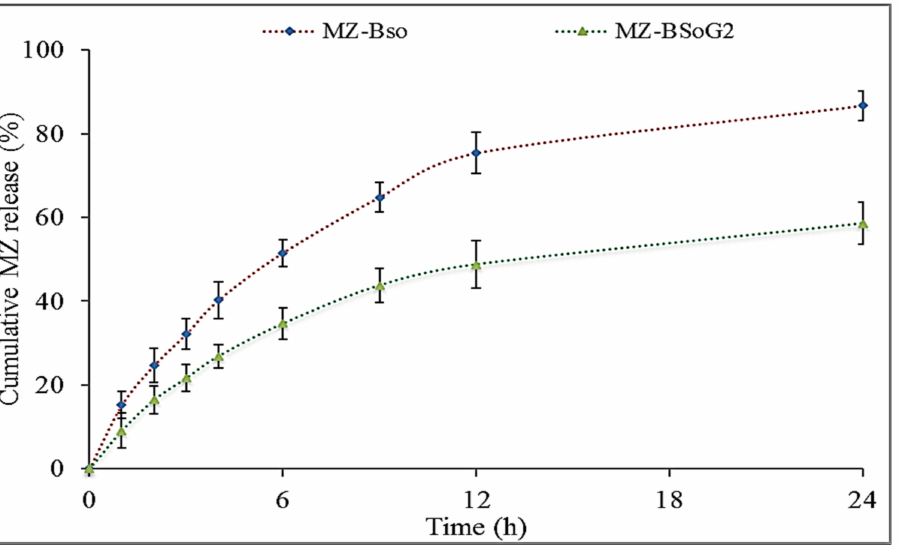
Figure 4. In vitro release data of miconazole bilosomes (MZBSos) and miconazole bilosome gel (MZBSoG). Study performed in triplicate, and data shown as mean ± SD. Statistical study compared between each group.